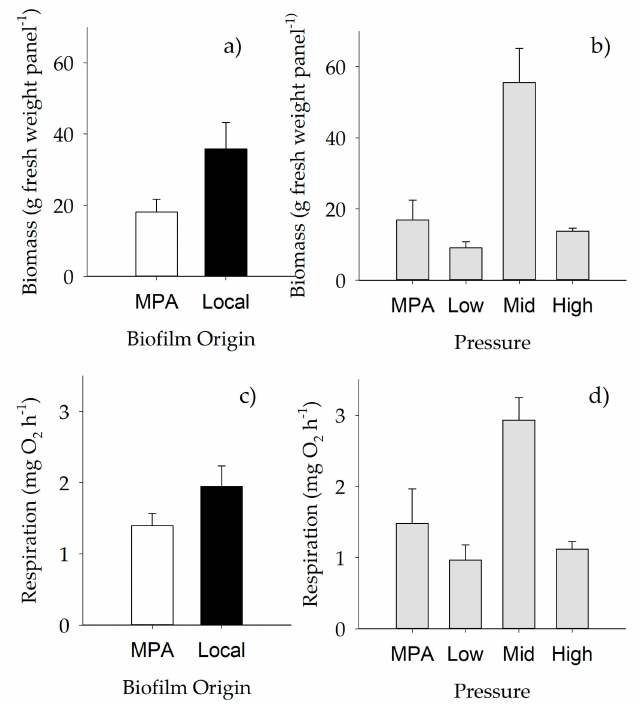
Figure 6. Mean ( + SE) biomass ( a , b ) and respiration rates ( c , d ) across di ff erent “Origin of biofilm” ( n = 30 for local, n = 40 for MPA) and “Pressure” levels. (a, c) White bars, MPA biofilm; black bars, local biofilm. For further details, see Table